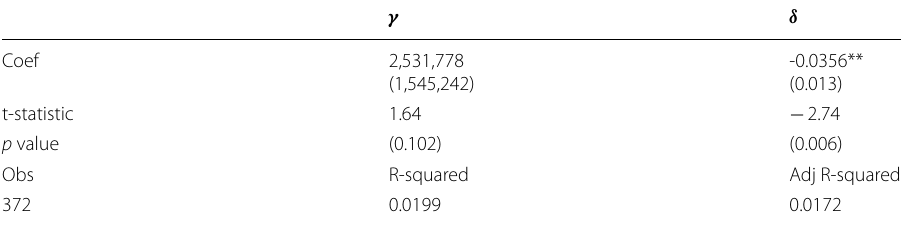
Table 2 Estimation results of �( IM t ) = γ + δ ∗ IM t − 1 + u t